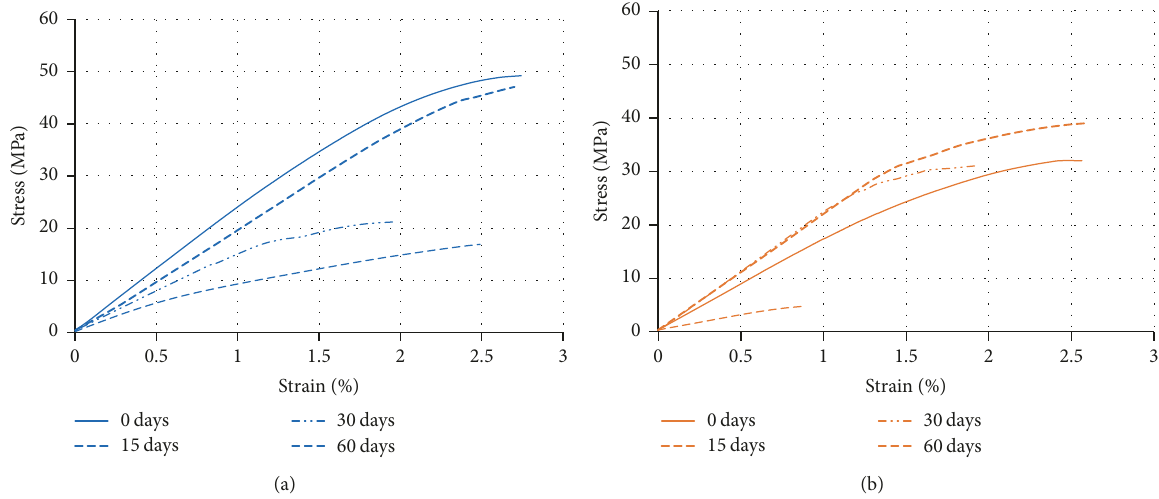
Figure 1: Representative stress-strain curves of PLGA low T (a) and PLGA high T (b) at all degradation time points obtained by flexural tests.